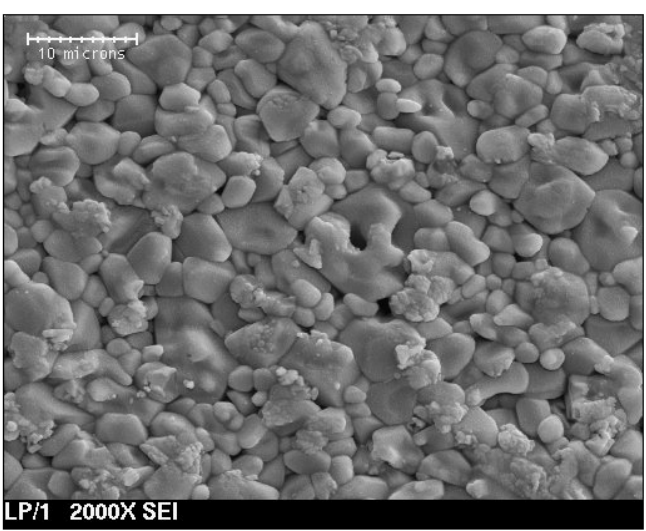
O /SiO thin films obtained at a magnification of 2 3